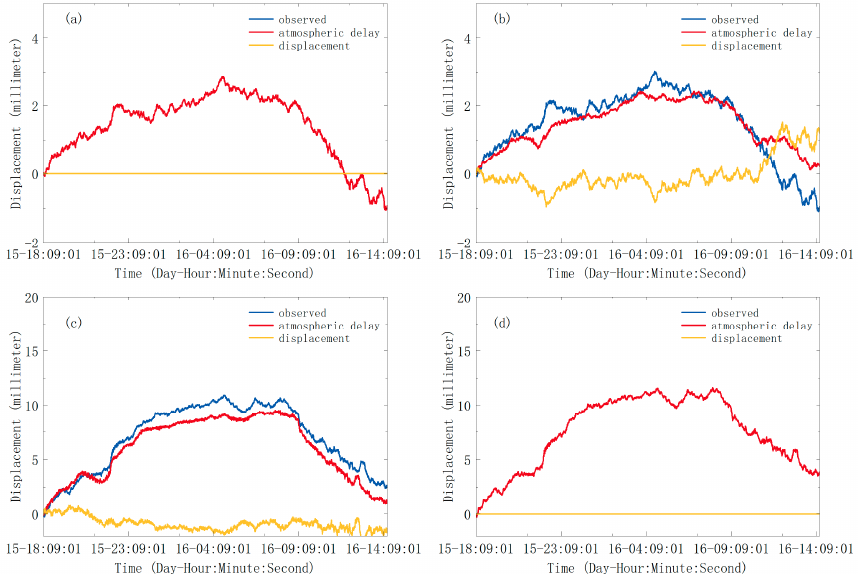
Figure 12. The time series obtained by the polynomial fitting method of four reflectors ( a ) P 1 , ( b ) P 2 , ( c ) P 3 , and ( d ) P 4 .